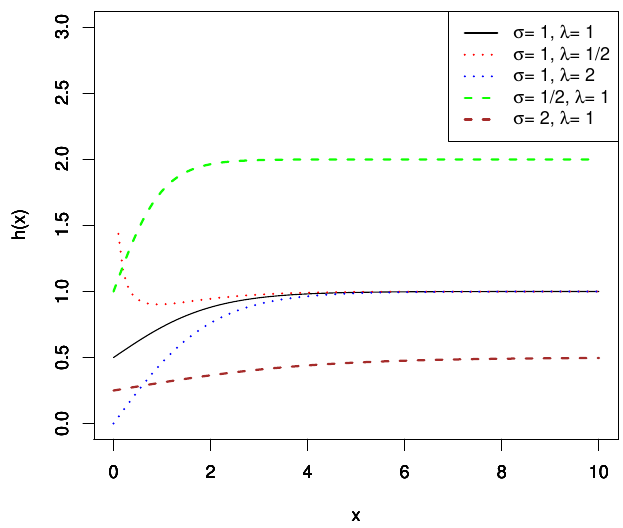
Figure 2. Failure rate function of exponentiated half-logistic